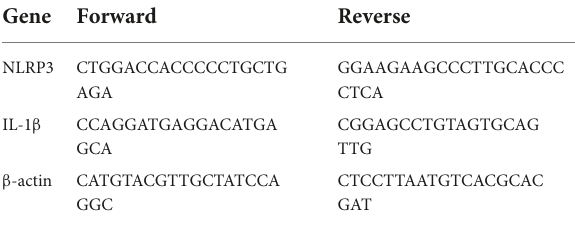
TABLE 1 Oligonucleotide primers used in RT-PCR